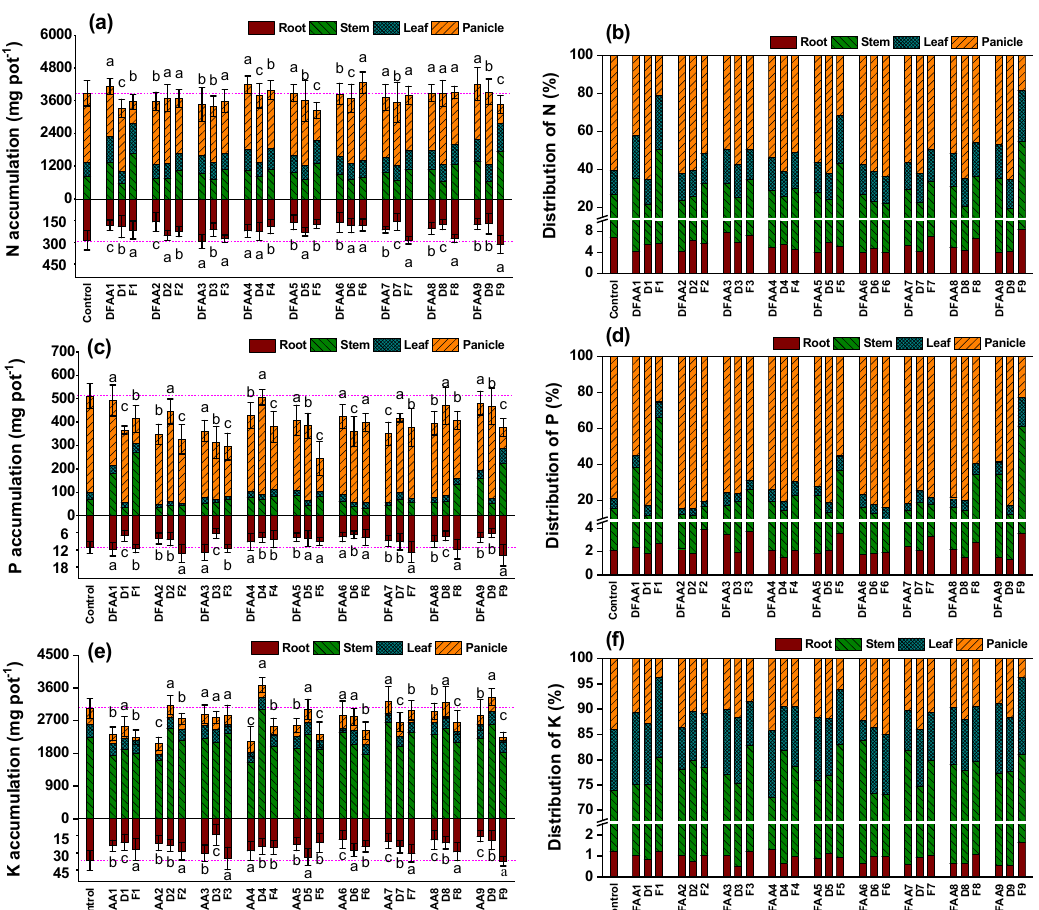
Figure 5. The accumulation ( a,c and e ) and partitioning ( b,d and f ) of tissue nitrogen (N), phosphorus (P) and potassium (K) in rice under different water stresses at maturity. Each treatment was performed on means of three years (n = 9 for DFAA1–DFAA9, D1–D3, D7–D9, F1–F3 and F7–F9, n = 6 for D4–D6 and F4–F6). Different letters indicate the significant difference at 0.05 level. DFAA, drought followed by flooding; D, drought followed by no flooding (drought alone); F, no drought followed by flooding (flooding alone).